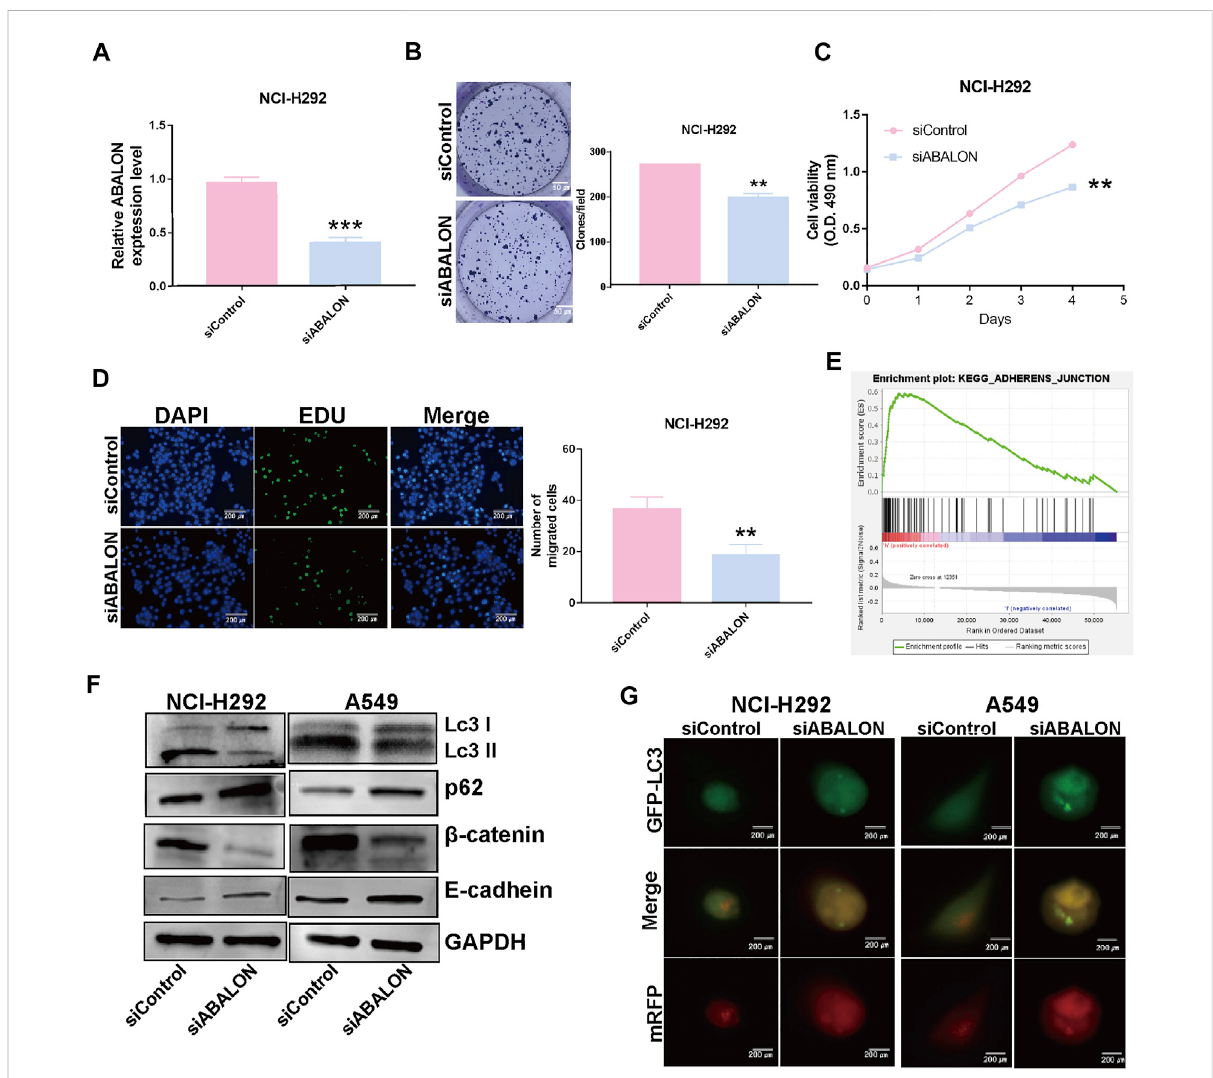
FIGURE 7 DownregulationofABALONsuppressedtheproliferationandmetastasisinNCI-H292cellsandpromotedautophagylevel. (A) RT-qPCRforthe expression of ABALON in siControl and siABALON NCI-H292 cells. (B – D) Colony formation (B) , MTT (C) , EDU (D) assays revealed cell proliferation promotion via downregulation of ABALON in NCI-H292 cells. (E) A signi fi cant enrichment results between ABALON-high and ABALON-low groups inNSCLC. (F) Westernblottingtoillustrate theexpression levelsofLC3- Ⅱ ,P62, E-cadherinand β -catenin. (G) TandemmRFP-GFP fl uorescence microscopy to illustrate the levels of autophagy. ** p <